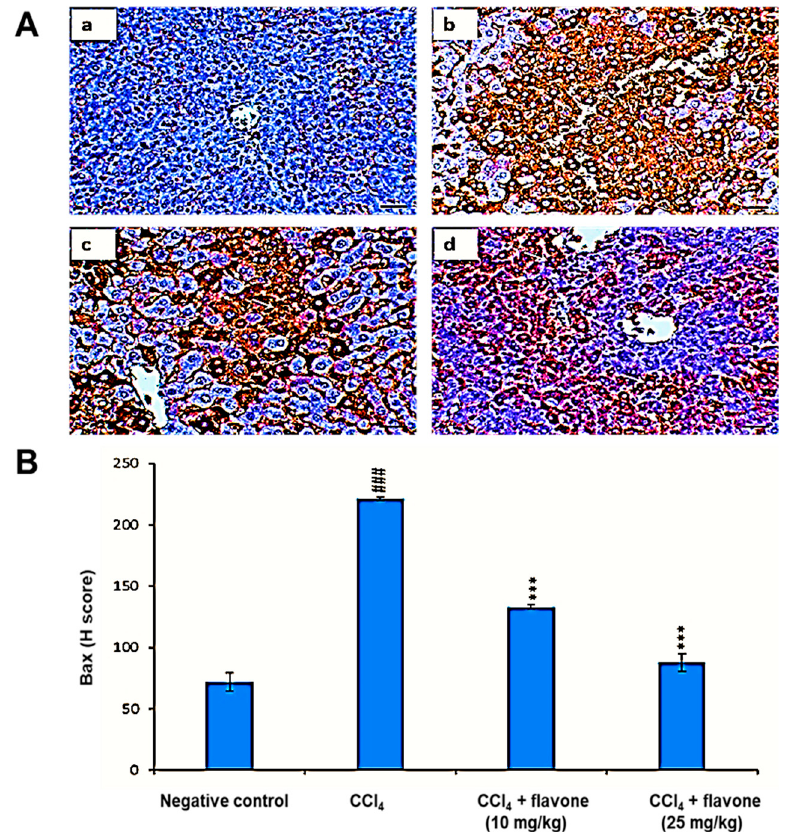
Figure 5. Effect of treatment with the flavone on the Bax protein level in liver tissues. A : Representative liver immunohistochemical graphs (a: negative control group, b: carbon tetrachloride (CCl 4 ) group, c: CCl 4 + flavone (10 mg/kg) group, d: CCl 4 + flavone (25 mg/kg) group); ( a ) showed a